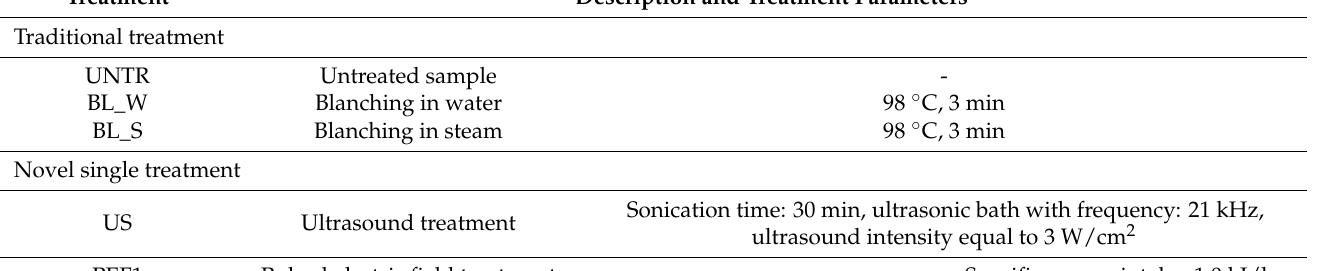
Table 1. Parameters of pretreatment preceded by shock freezing (L) and vacuum freezing (L_VF) of freeze-dried red bell pepper. Description and Treatment